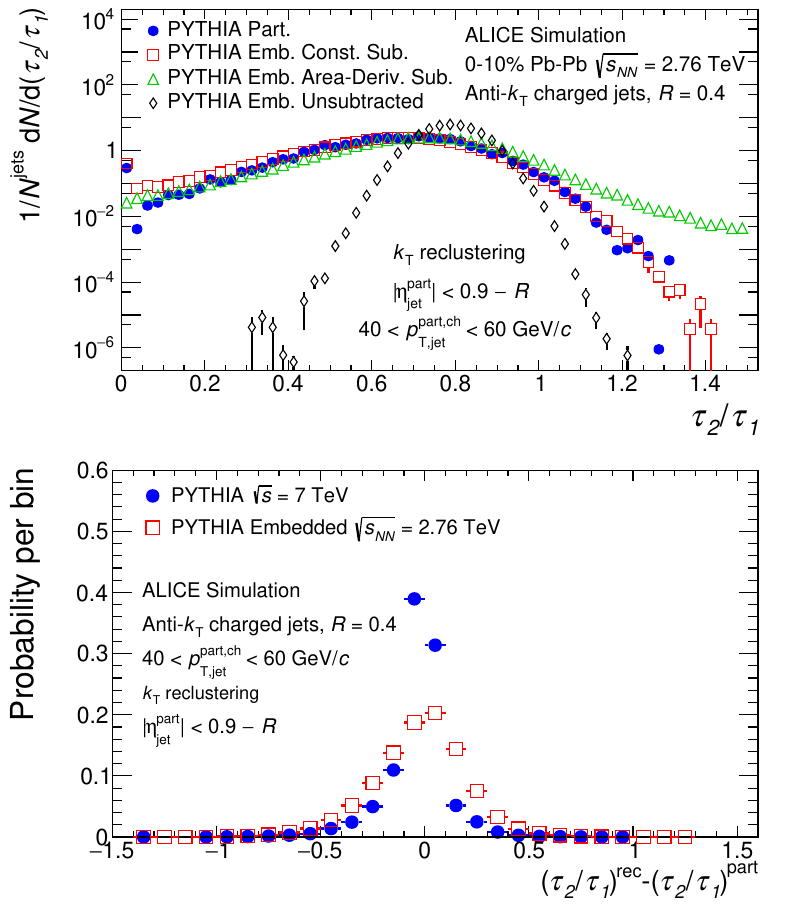
Figure 3 . Left: the performances of the constituent (squares) and area-derivatives (triangles) subtraction methods on the τ observable, measured with the k reclustering algorithm, are 2 /τ 1 T evaluated by embedding PYTHIA MC events into real Pb-Pb data. The filled circles represent the case with no heavy-ion background and the diamonds represent the case with background but no subtraction. Right: the τ residual distributions characterising the observable resolution due to 2 /τ 1 detector effects and uncorrelated background. Both plots are shown for 40 < p part , ch < 60 GeV/ c T , jet